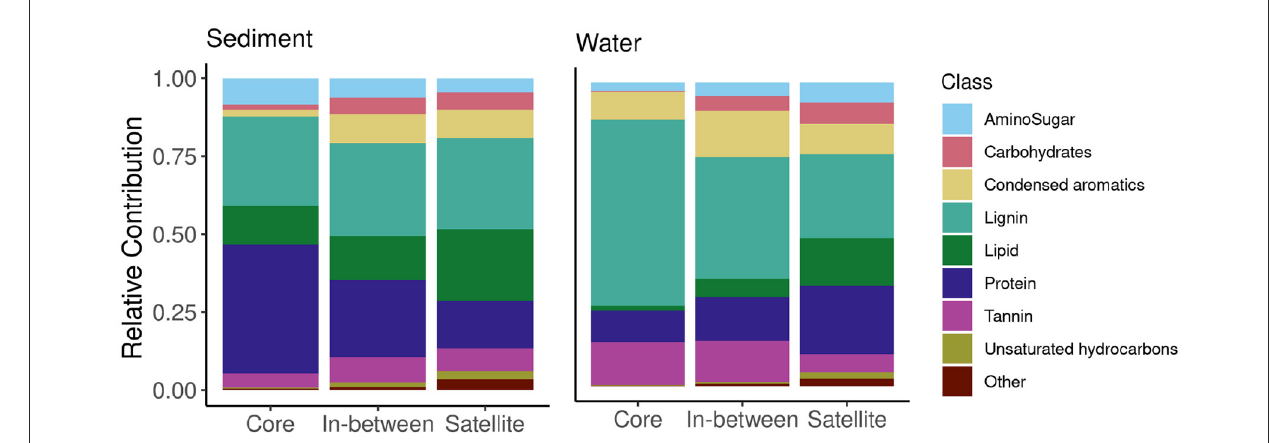
FIGURE2 Relative contribution (%) of potential compound classes to core, in-between and satellite molecular formulae in sediment and water